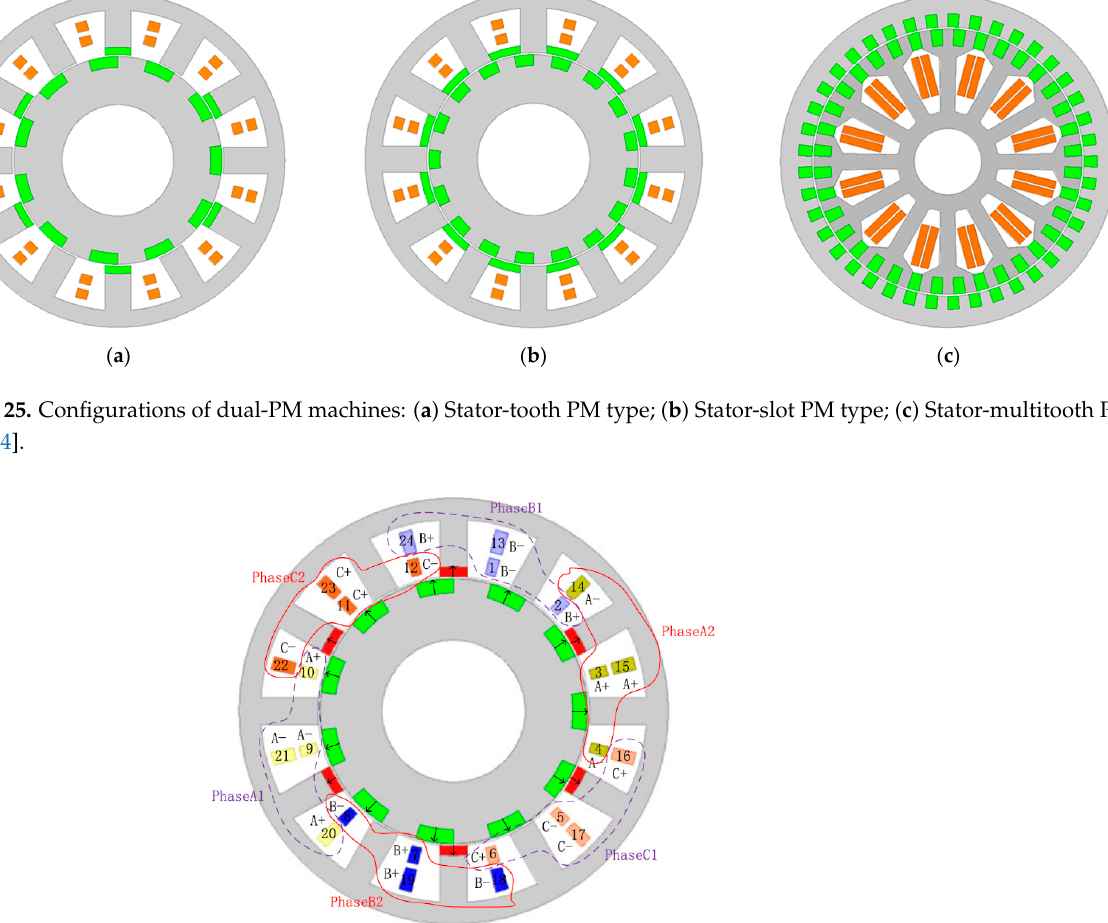
Figure 25. Configurations of dual-PM machines: ( a ) Stator-tooth PM type; ( b ) Stator-slot PM type; ( c ) Stator-multitooth PM type [54].